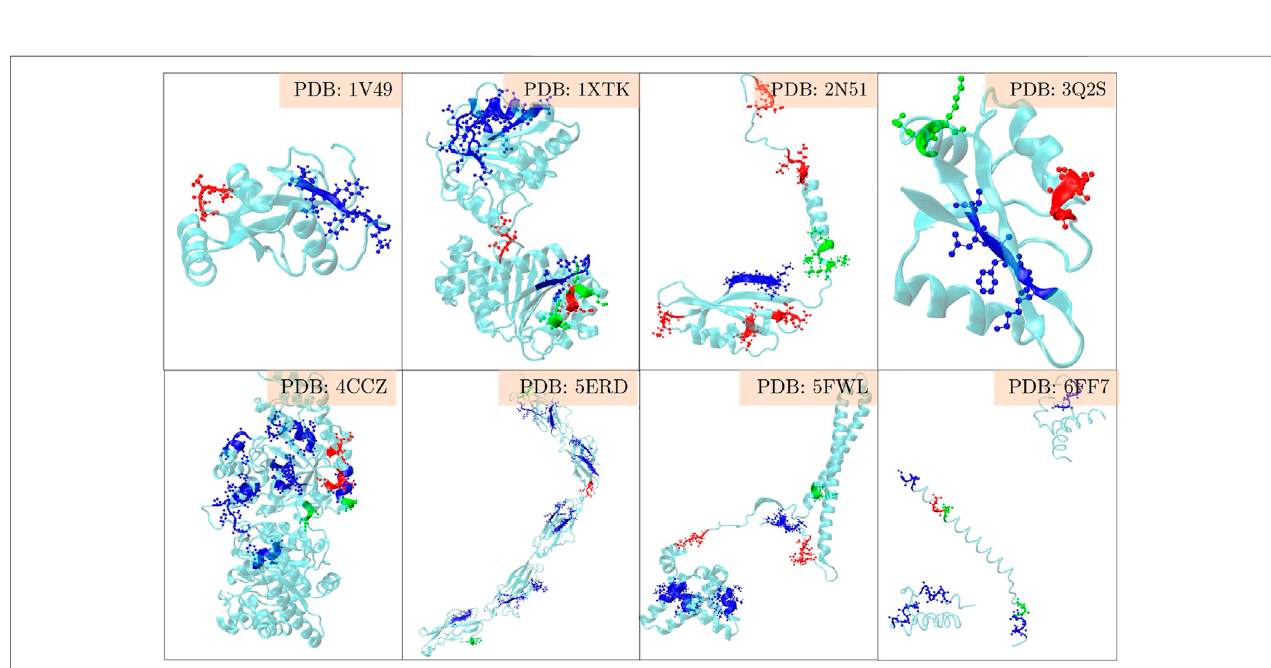
FIGURE 4 | An analysis of the structural-proximity of the triacidic as well as the KKX motifs with all LIR motifs occurring among the proteins from the class I of the UCPS-ATG data set for which structures are known is shown. The blue, green and red colors indicate the LIR, KKX and triacidic motifs. One may notice that in some structures LIR is close to the triacidic motif, and in others to the KKX motif.